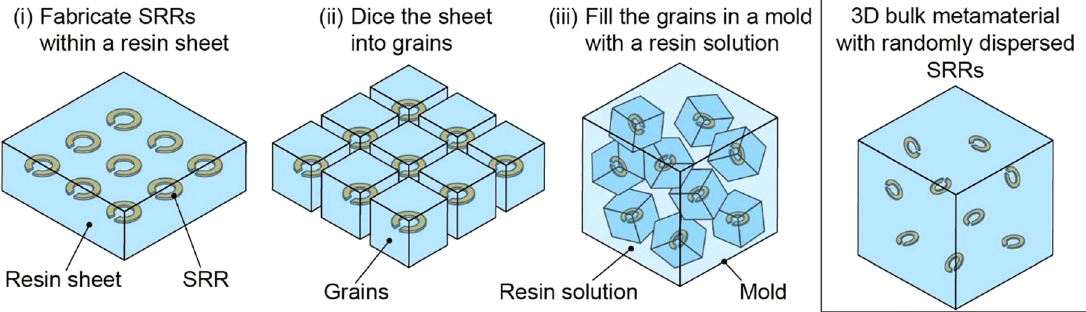
Figure 1: Conceptual sketch of the proposed 3D bulk metamaterial with randomly dispersed SRRs and its fabrication